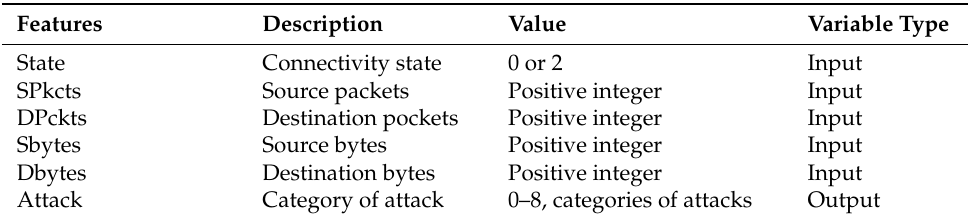
Table 2. UNSW-NB15 Dataset